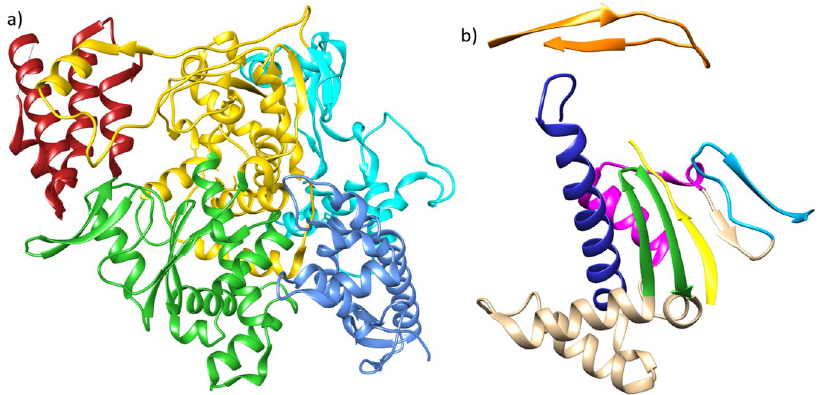
Figure 1. Three-dimensional structure of the SARS-CoV RNA-dependent RNA-polymerase (nsp12) and its palm subdomain. ( a ) The RdRp subdomains are colored as follows: thumb – red; palm – green; fingers – yellow; nidovirus RdRp-associated nucleotidyl transferase (NIRAN) domain – blue; interface – cyan. ( b ) The conserved structural motifs within the palm subdomain and conforming the active site are colored as follows: motif F – orange; motif A – yellow; motif B – blue; motif C – green; motif D – magenta; motif E –